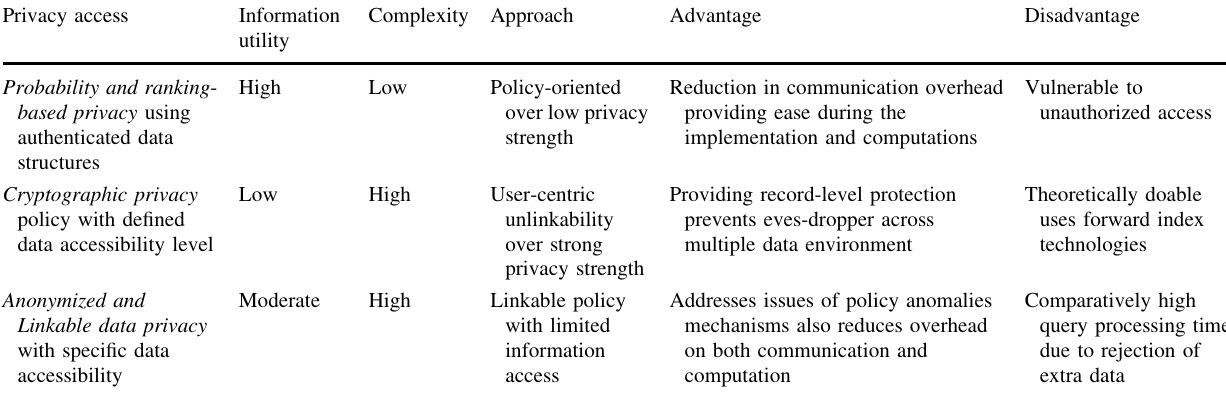
Table 7 Representing information utility and complexity on the basis of nature of various privacy